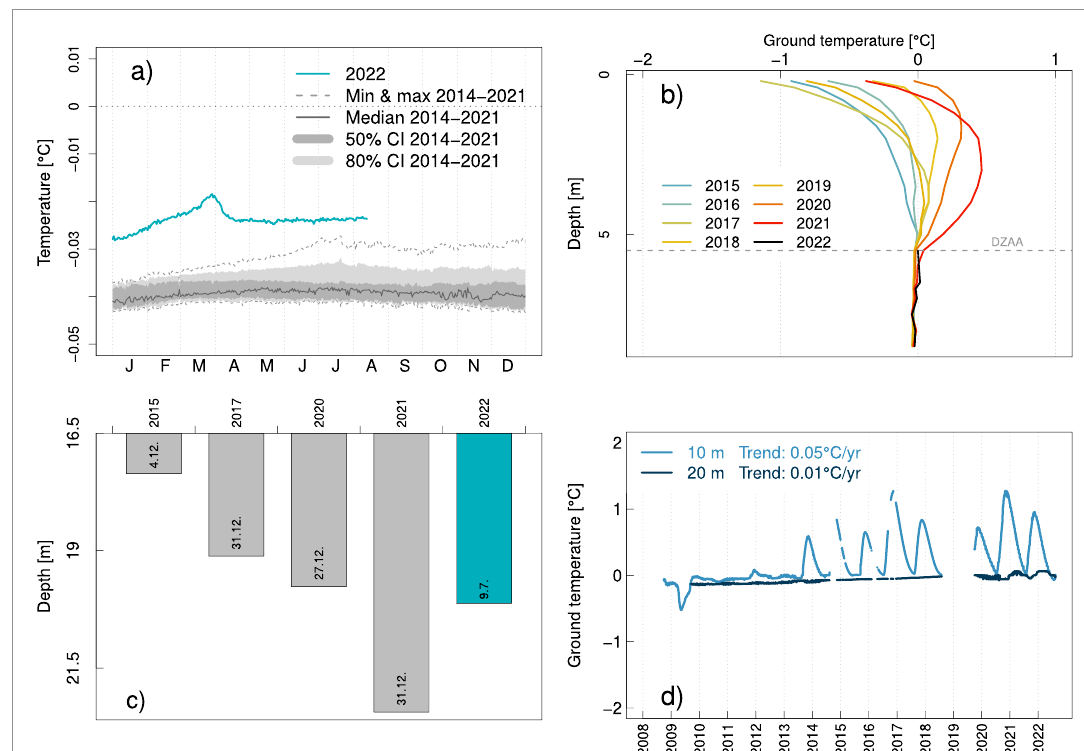
Figure 3. Thawing permafrost at Snøheim (top) and Iskoras (bottom): ground temperature at the permafrost surface at 8.5 m depth (a); mean annual ground temperature profiles and mean depth of DZAA (b); maximum annual depth of the 0 ◦ C isotherm and the corresponding day (c) and long-term changes in permafrost thermal state at 10 m and 20 m depth (d). Time series for 2022 includes data until 14 August 2022.